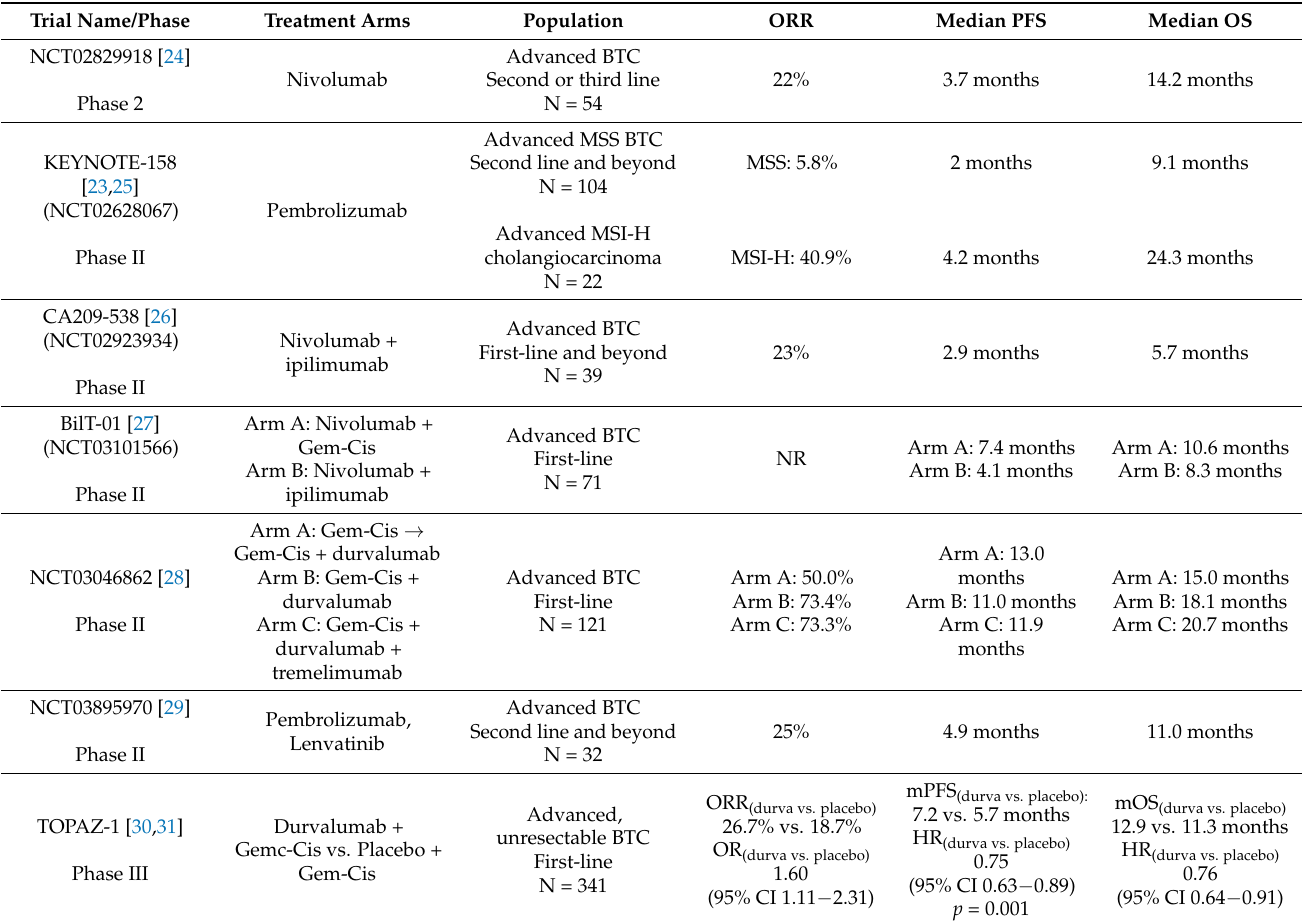
Table 1. Results reported from phase II/III clinical trials investigating immune checkpoint inhibitors in advanced